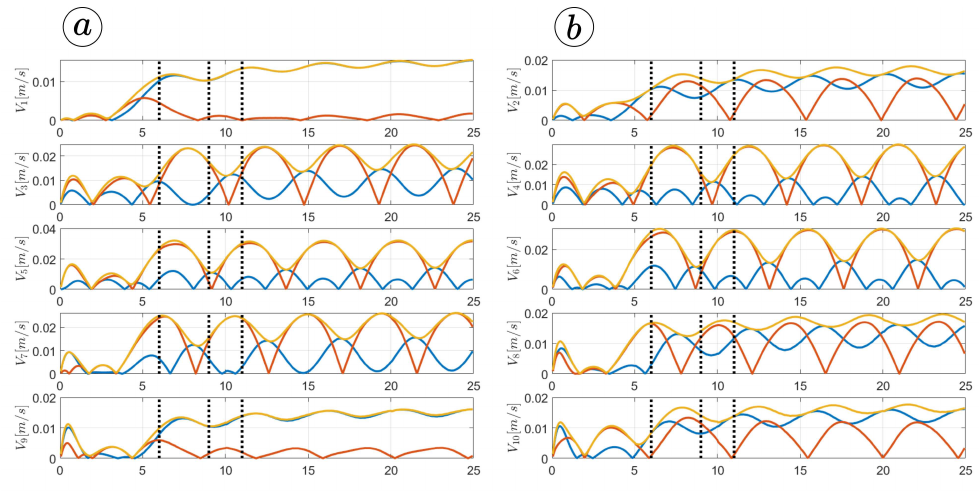
Figure 13. Velocities of the snake robot’s segments for c t = 0.1 ( a ) and c n = 10 ( b ).